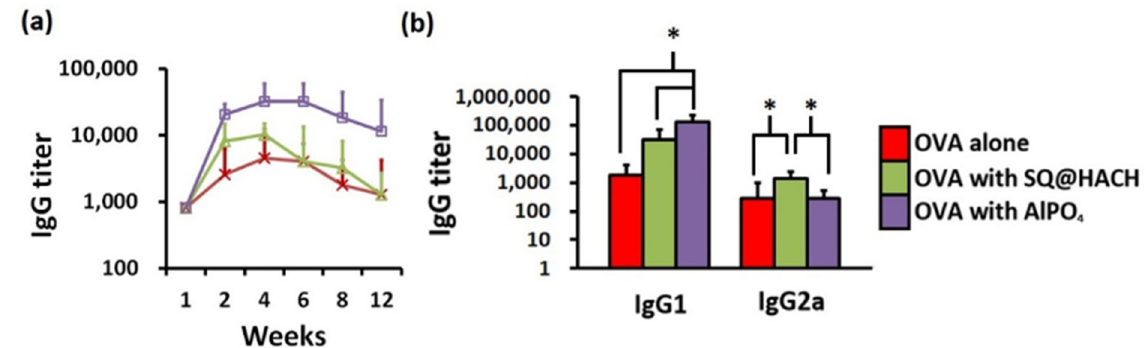
Figure 5. The impact of adjuvants on driving OVA-specific IgG antibodies in mice ( n = 6 per group) treated with OVA alone, OVA with SQ@HACH and OVA with AlPO 4 for 12 weeks. ( a ) IgG ( b ) IgG subtypes. The serum samples from immunized mice were collected for analysis by ELISA. The IgG subtypes were further analyzed in Week 4 by ELISA. The data are shown as the GMT ± 95% C.I. * p < 0.05.